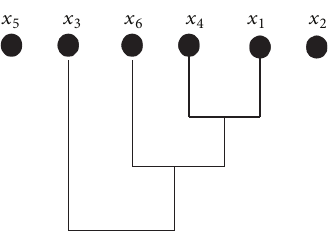
Figure 2: Clustering